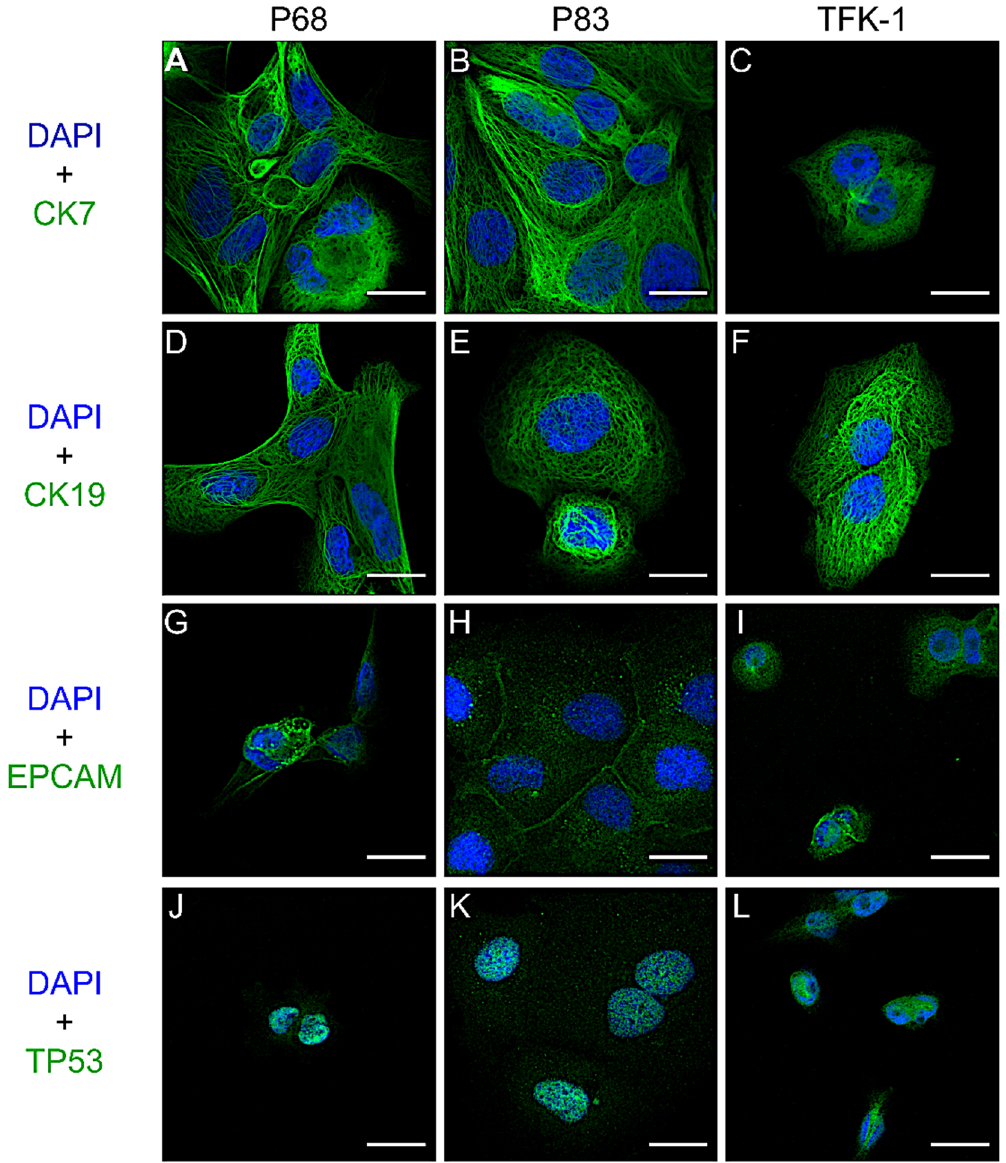
Figure 4. Immunofluorescence staining of patient-derived cell lines. CK7 ( A – C ), CK19 ( D – F ), EPCAM ( G – I ), and TP53 ( J – L ) stainings on P68, P83, and TFK-1 cells. Scale bar, 50 µm.